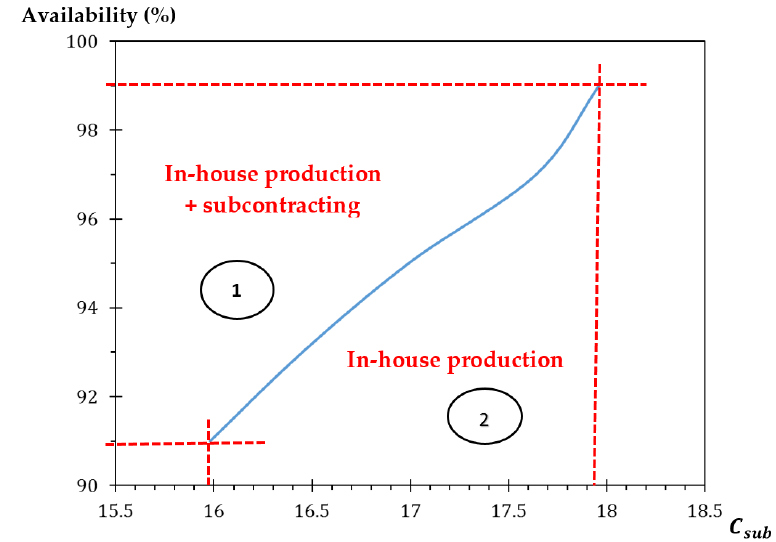
Figure 6. Indifference curve to determine the subcontractor participation.